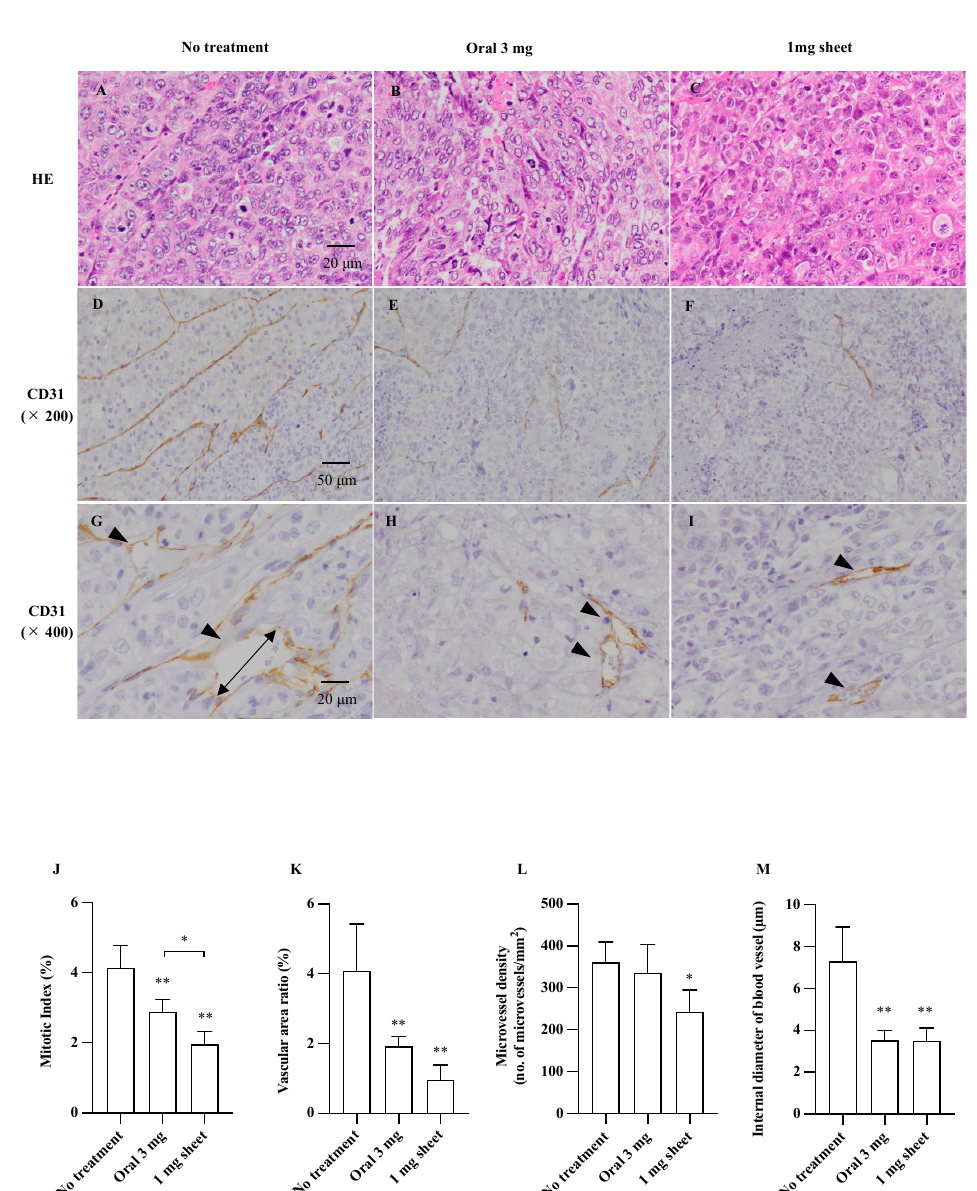
Figure 4. Immunohistochemical analysis of subcutaneous tumors. Formalin-fixed paraffin-embedded tumor sections were stained with H&E ( A – C ; 400 × , bar = 20 µ m) and anti-CD31 antibody ( D – I ). Representative images of vessel walls stained with CD31 ( D – F ; 200 × , bar = 50 µ m), and cross- section of vessel ( G – I ; 400 × , bar = 20 µ m). Arrowheads indicate microvessels. Quantification of MI ( J ), vascular area ratio ( K ), MVD ( L ), and internal diameter of vessels ( M ). Data are presented as means ± standard deviations ( n = 5). The p -values between the indicated groups are presented as * p < 0.05 and ** p < 0.01. Table 3. Immunohistochemical data analysis.